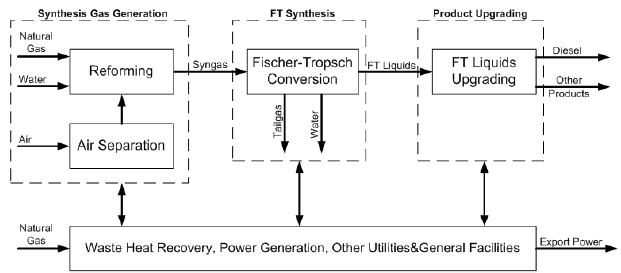
Figure 1: Overview of the GTL process Source: Adapted from Djakovic